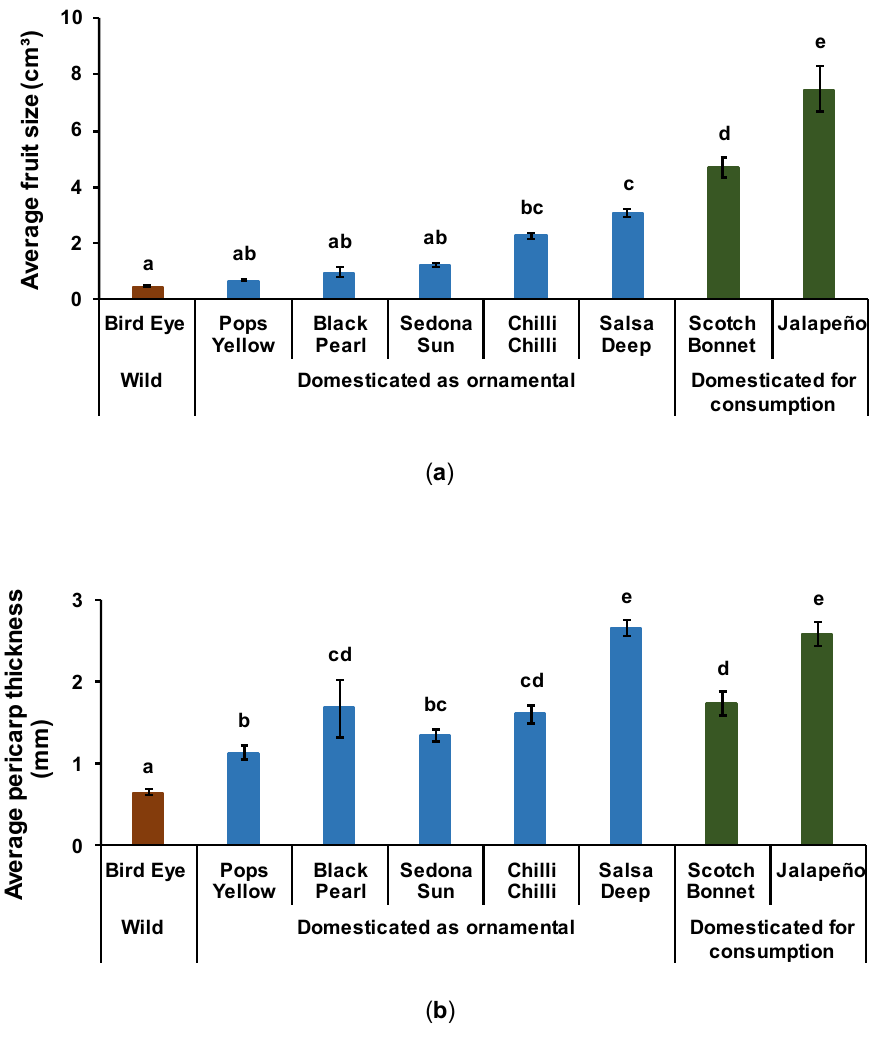
Figure 3. Effect of chili domestication on fruit size ( a ) and pericarp thickness ( b ). Sample size: Bird Eye (N = 25); Pops Yellow (N = 20); Black Pearl (N = 25); Sedona Sun (N = 30); Chilli Chilli (N = 20); Salsa Deep (N = 41); Scotch Bonnet (N = 32); Jalapeño (N = 62). The differences among treatments are indicated by different letters (F-test, Tukey’s post-hoc test with Bonferroni correction: p < 0.001).